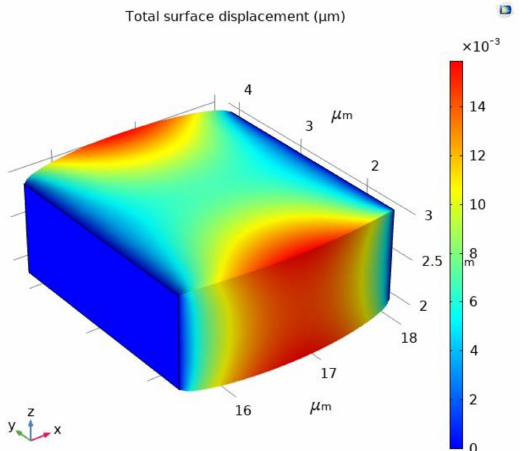
Figure 9. The displacement of the sample surface when the electric field intensity is 150